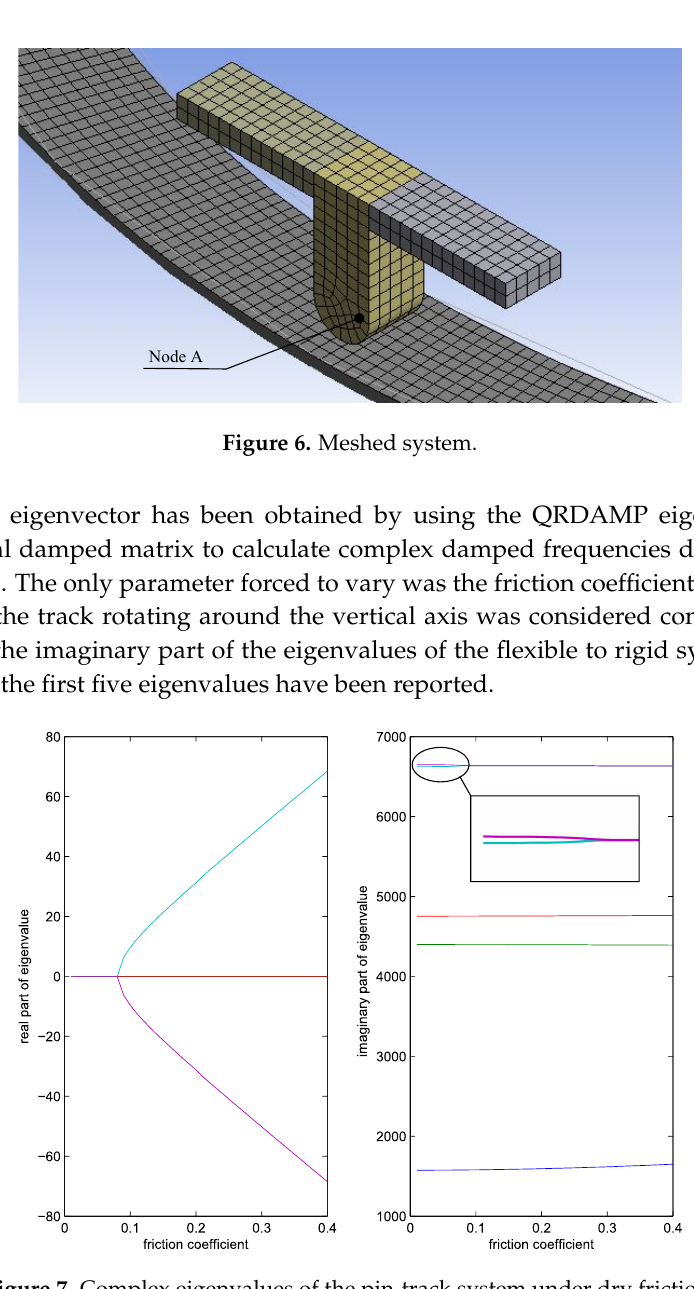
Figure 7. Complex eigenvalues of the pin-track system under dry